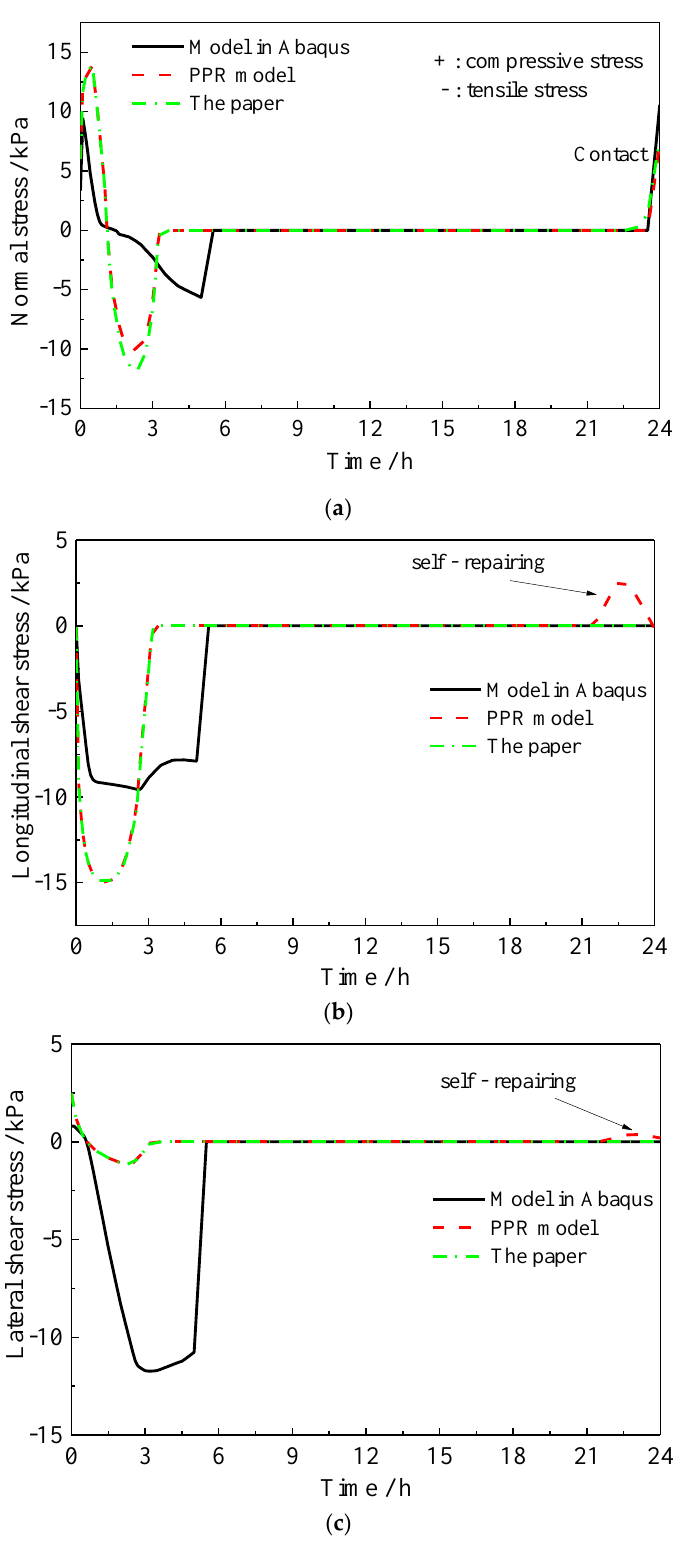
Figure 22. Interface stresses of slab corner varying with time: ( a ) normal stress, ( b ) longitudinal shear stress, and ( c ) lateral shear stress.